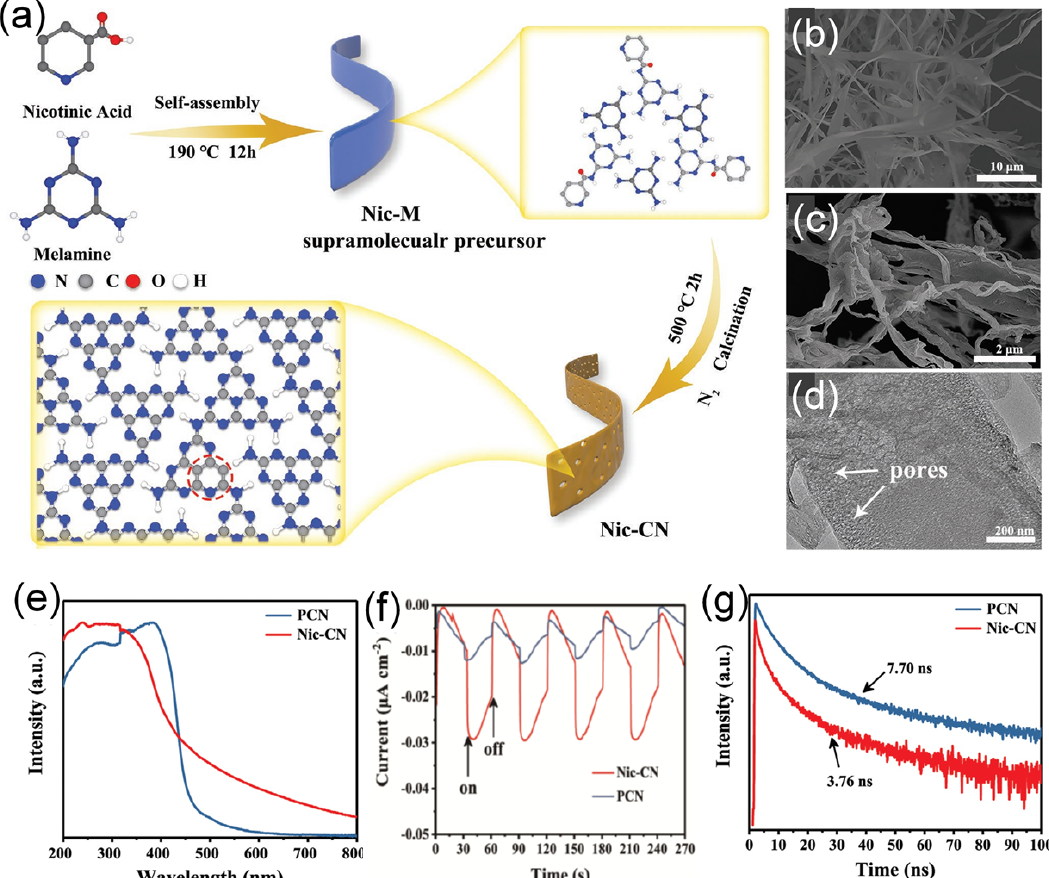
Figure 10. ( a ) Schematic illustration of the synthesis process of Nic-CN. SEM image of ( b ) Nic-M precursor and ( c ) Nic-CN. ( d ) TEM image of Nic-CN. ( e ) UV-vis DRS of PCN and Nic-CN, ( f ) transient photocurrent responses of PCN and Nic-CN, and ( g ) transient state PL spectra of PCN and Nic-CN. Adapted with permission from Ref. [138]. 2021, John Wiley & Sons, Inc.